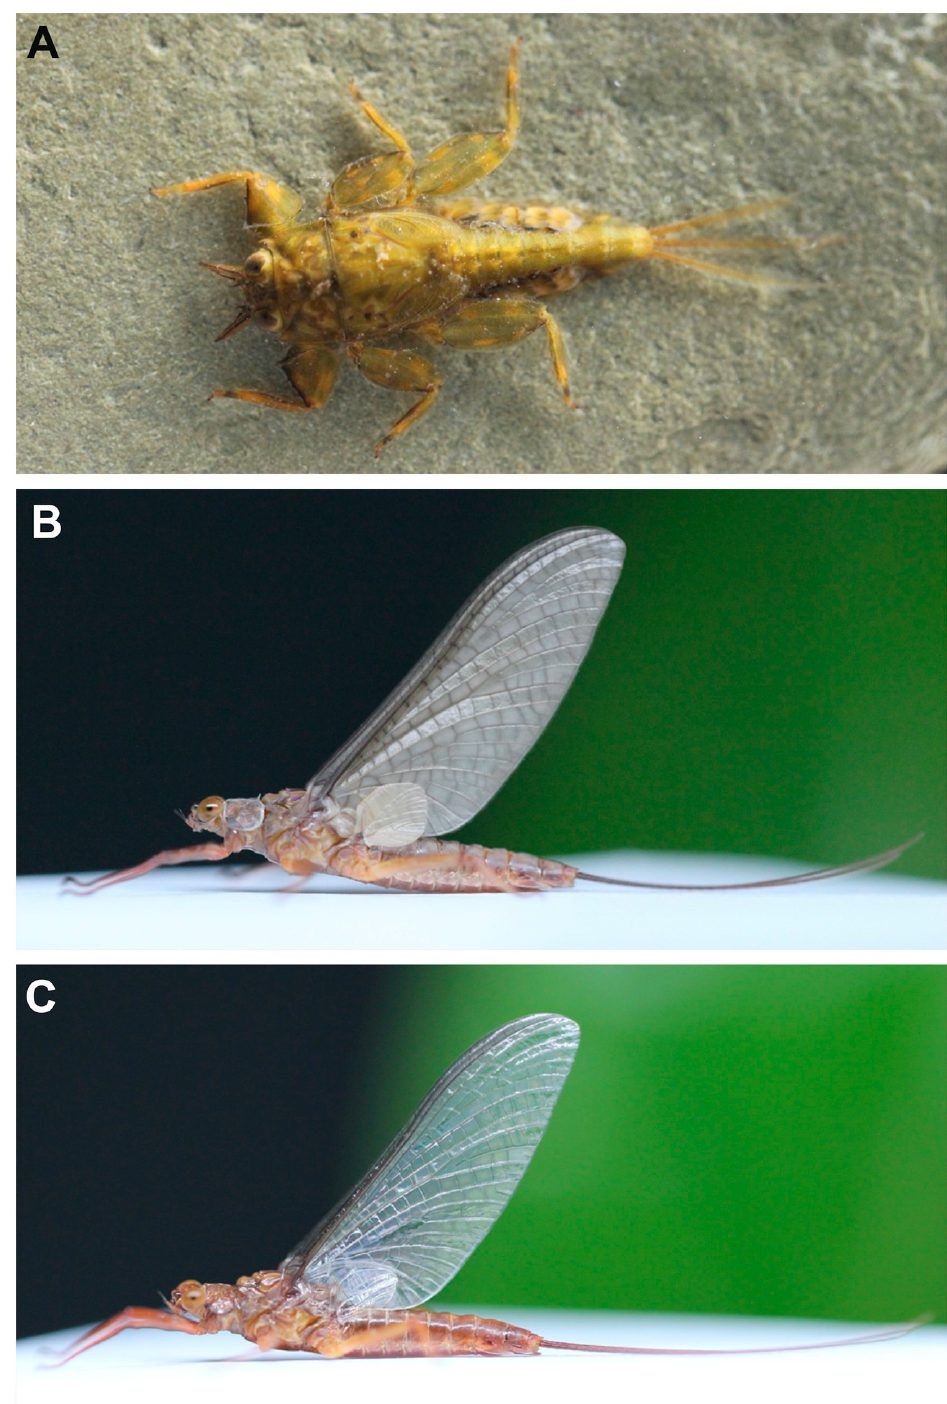
Figure 7. Vietnamella nanensis sp. n. ( A ) habitus of larva; ( B ) habitus of female subimago; ( C ) habitus of female imago.